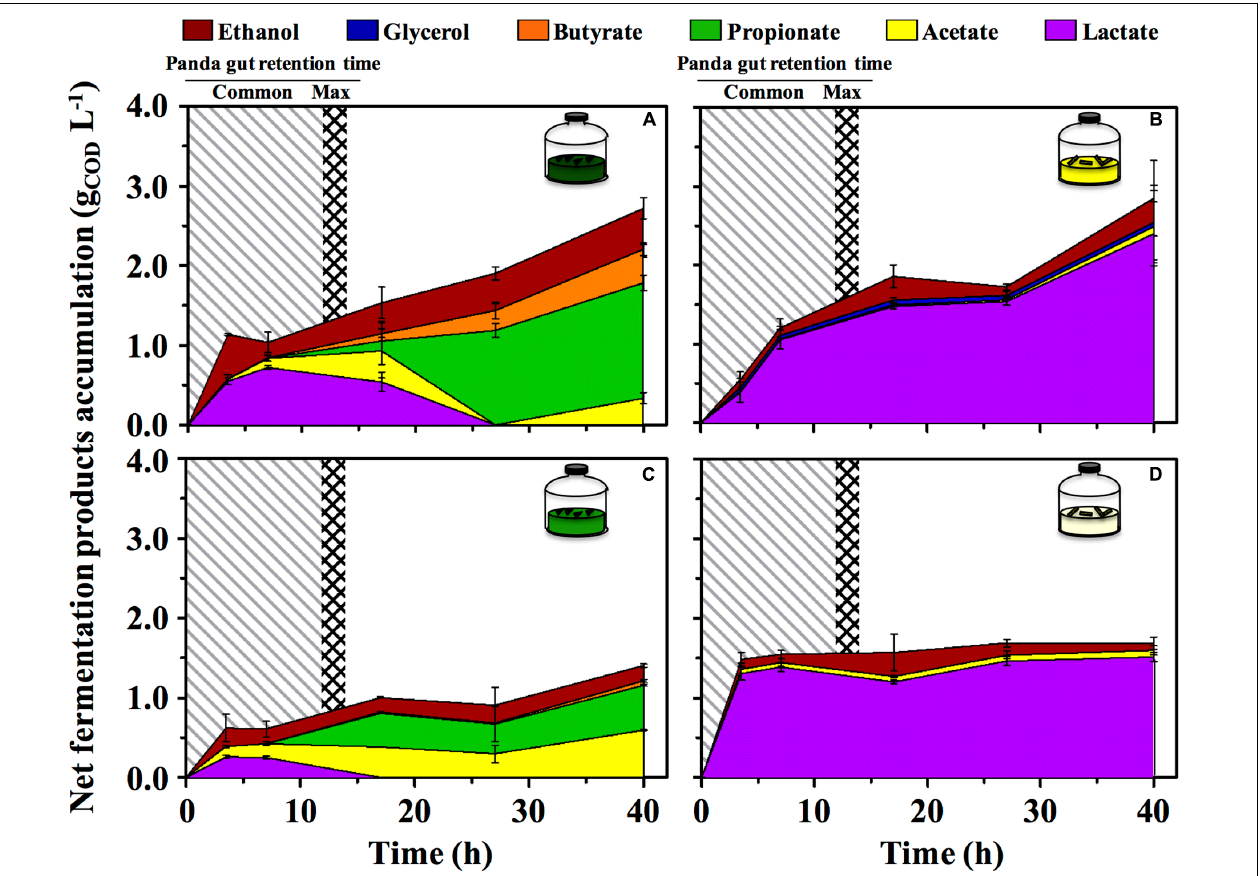
FIGURE 4 | Net fermentative products accumulation in laboratory-scale fermentation tests ( n = 3) using microbiomes derived from giant panda fecal samples ( Figure 2 ): (A) Green inoculum + leaf; (B) Yellow inoculum + pith; (C) De-H 2 O green inoculum + leaf; (D) De-H 2 O yellow inoculum + pith. Common [generally up to 12 h (Dierenfeld et al., 1982; Mainka et al., 1989; Edwards et al., 2006; Senshu et al., 2007)] and maximum [14 h (Schaller et al., 1985)] gut retention times observed in giant pandas are indicated with shaded areas. Keys reported in the